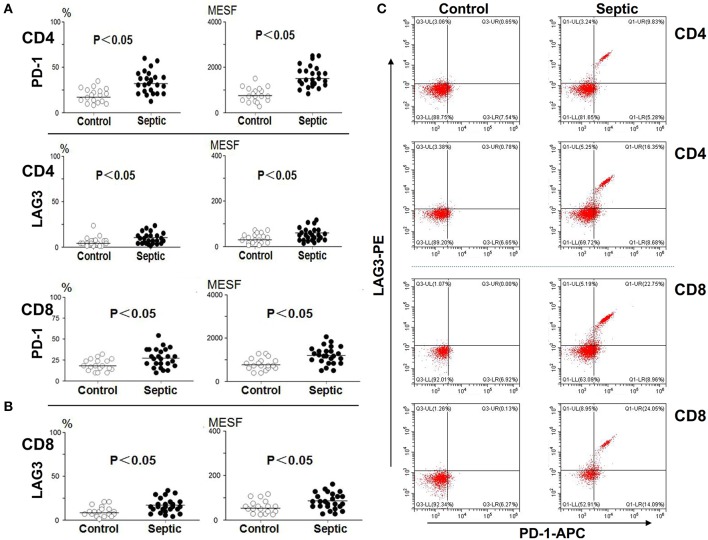
The expression of LAG3 and PD-1 on CD4 and CD8 T on the 5th day of the sepsis. The peripheral blood of septic patients and controls were collected at enrollment and again 5 days later, and analyzed by flow cytometry for the expression of the indicated markers on CD4 T cells and CD8 T cells. The positive proportion and MESF values were obtained as described in the procedures. The horizontal lines represent the mean levels. Scattergram (A) and (B) showed the expression of LAG3 and PD-1 on CD4 and CD8 Tcells, respectively. Representative flow cytometry pictures (C). P-values were calculated with a non-parametric 2-tailed Mann-Whitney U test.